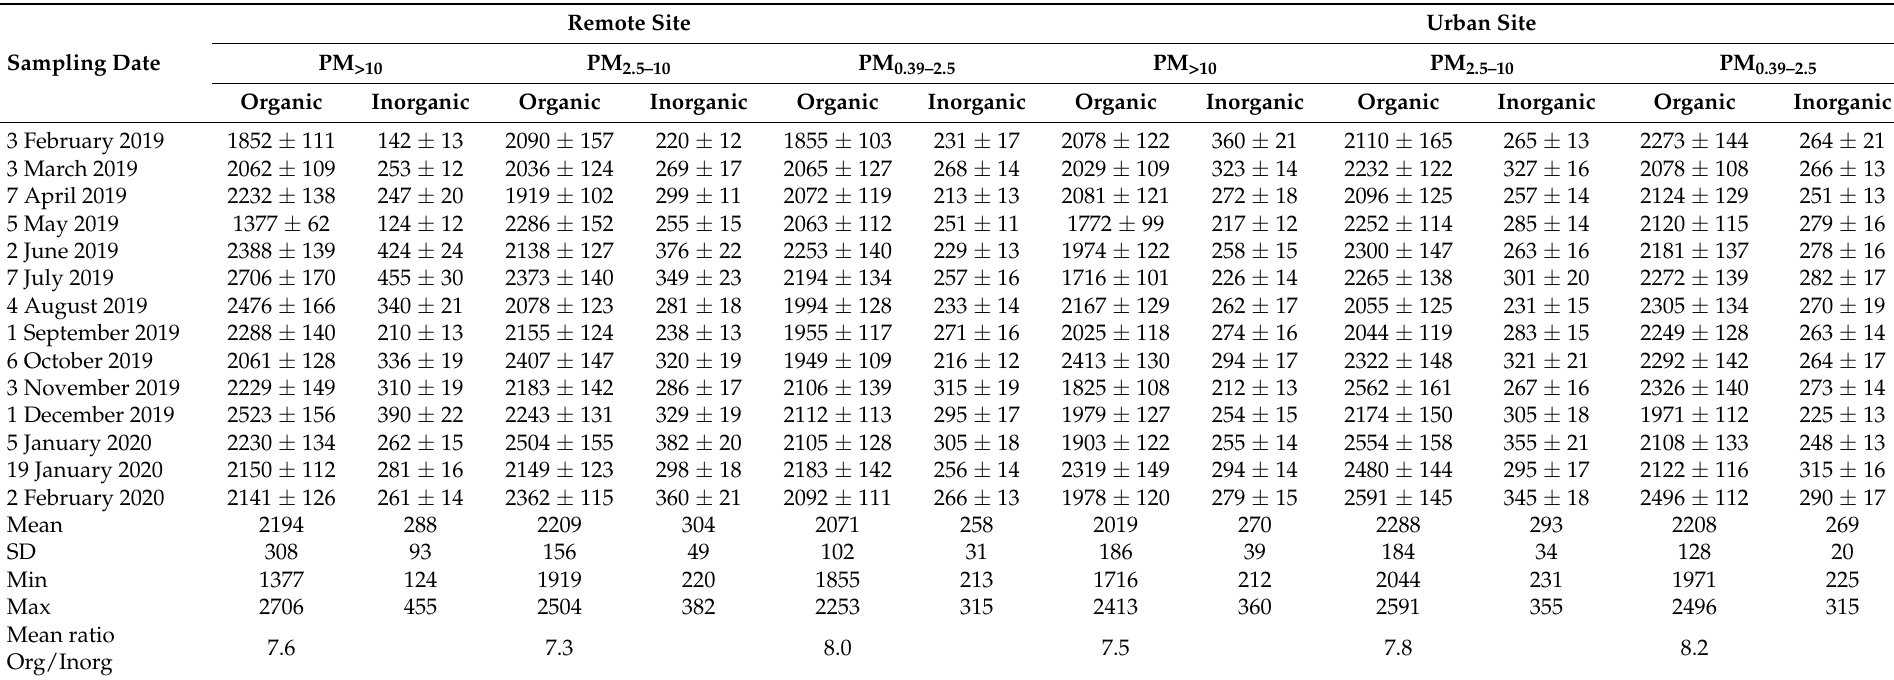
Table 2. Polonium-210 activity concentrations (mBq/g dry weight ± 1 σ ) in organic and inorganic components of size fractioned aerosol